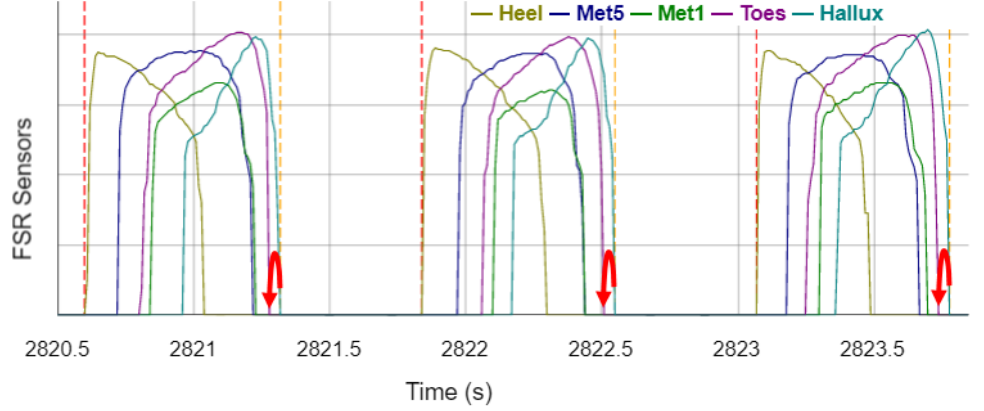
Figure 8. FSR-sensor signals of the sock during three stance phases. Vertical dashed lines visualize the events detected by the algorithm (Vertical dotted lines legend: red: IC sock ; orange: TO sock ). Red arrows visualize optimization opportunities.